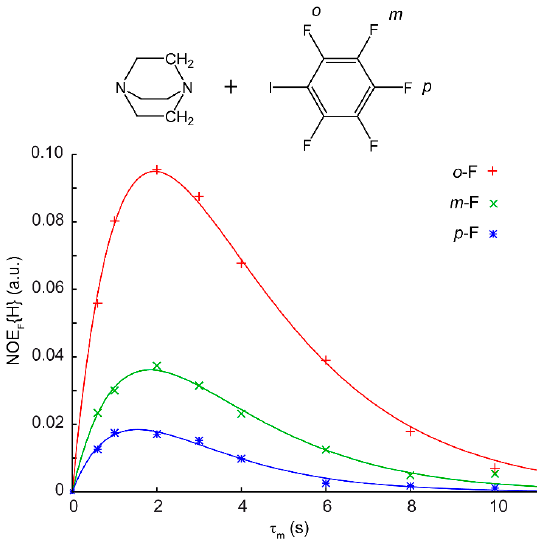
Figure 1. Adapted with permission from reference [61]. Experimental data relative to the intensity of nuclear Overhauser effect (NOE) on the fluorine nuclei of iodopentafluorobenzene as a function of τ m after the irradiation of CH 2 protons of DABCO . The straight lines are the best fitting functions using Equation (5). Copyright 2015 Wiley-VCH Verlag GmbH & Co. KGaA.